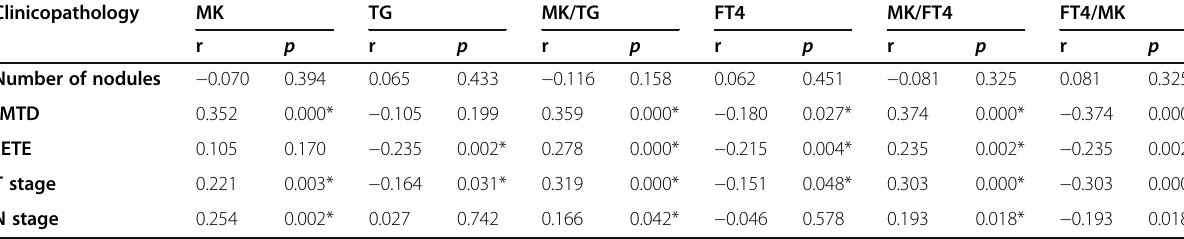
Table 4 Correlation between MK ratios and clinicopathological features Clinicopathology